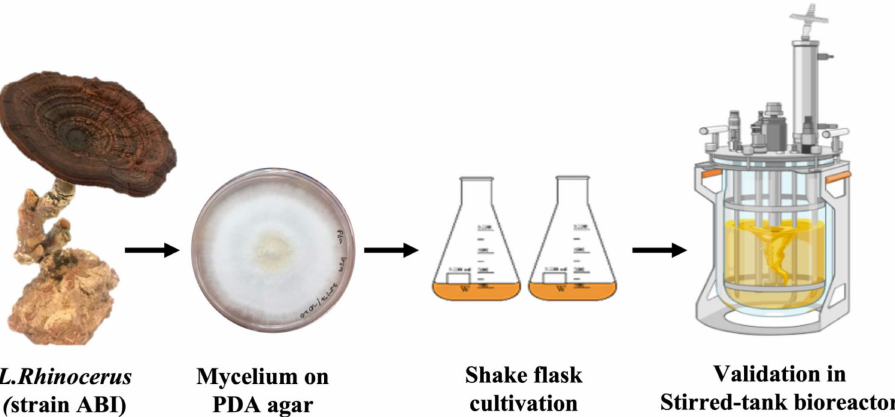
Figure 1. Process flow of the submerged liquid fermentation of L. rhinocerus strain ABI, starting from the culture of the fruiting body to cultivation in the stirred-tank